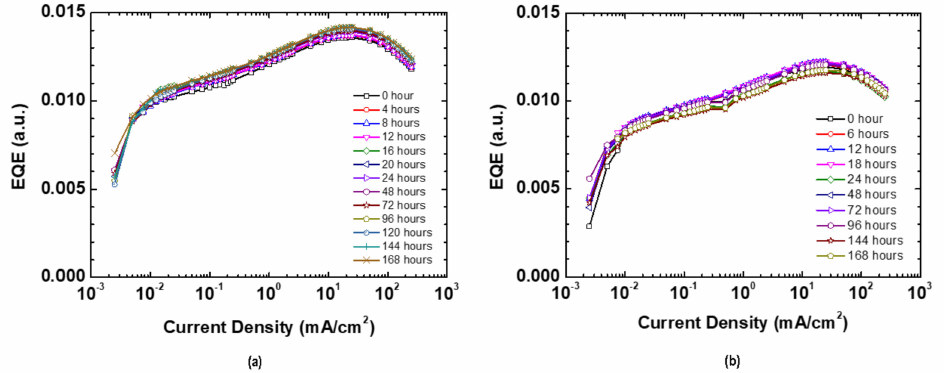
Figure 7. Device EQEs under constant current stresses at ( a ) 2.5 × J D and ( b ) 15 × J D .